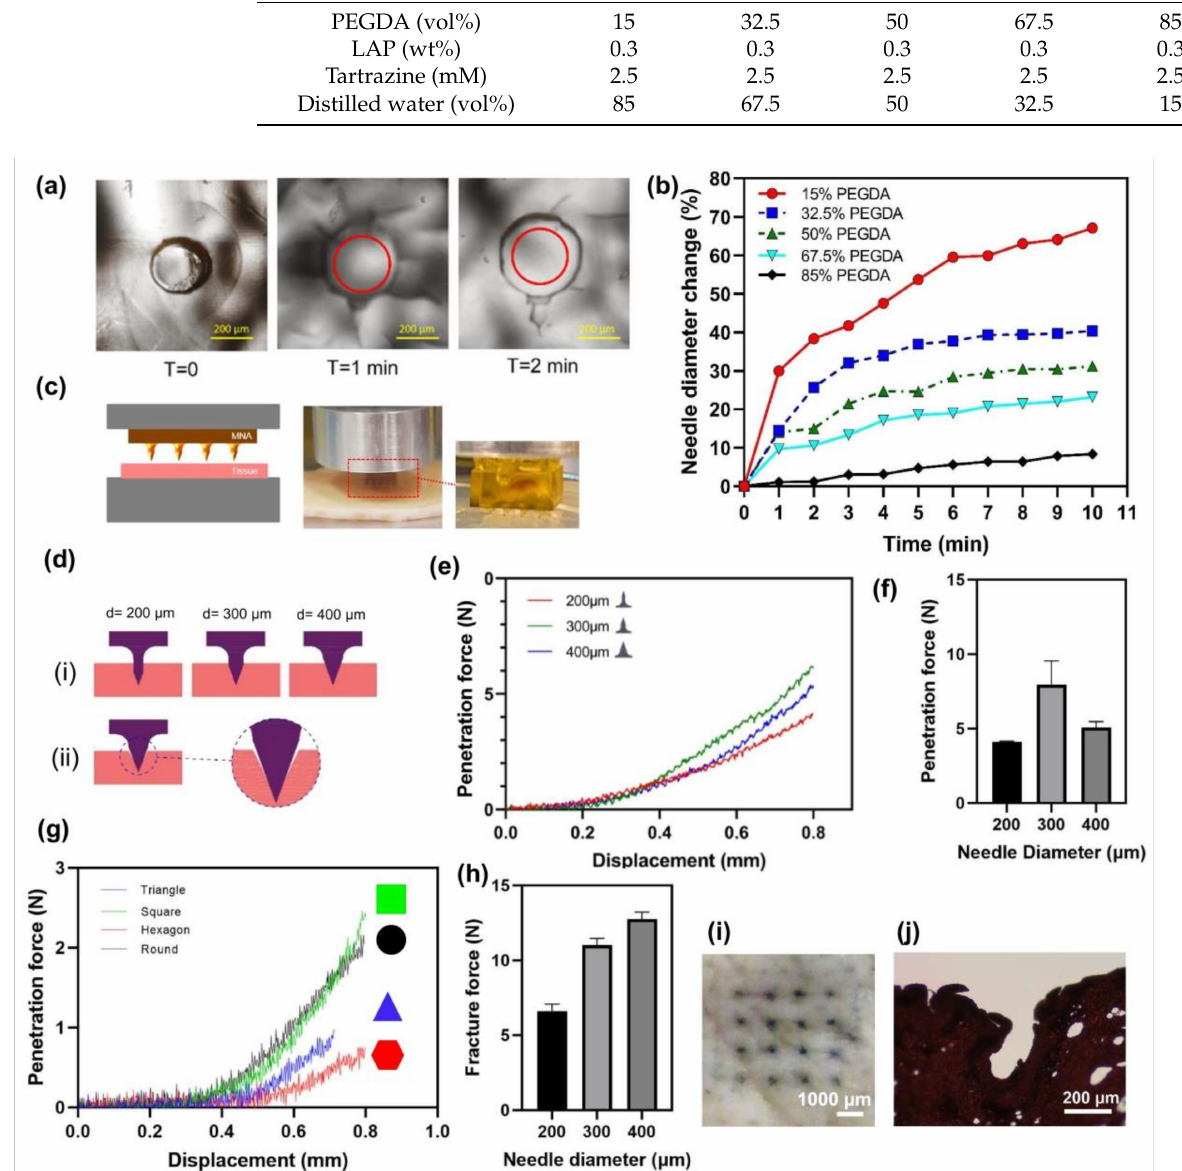
Figure 4. Swelling and mechanical properties. ( a , b ) Changes of the MN diameter at different times of swelling test; ( c ) Mechanical testing device; ( d ) Schematic illustration of MNs penetration with different diameters; ( e ) Penetration force versus displacement for round MNAs with different diameters; ( f ) Maximum penetration force of round MNAs with different diameters; ( g ) Penetration force for MNAs with different cross-section shape; ( h ) Fracture force of MNAs with different needle diameters; ( i ) Top view of pig skin after MNA insertion using blue dye; and ( j ) Stained section of pig skin penetrated by the